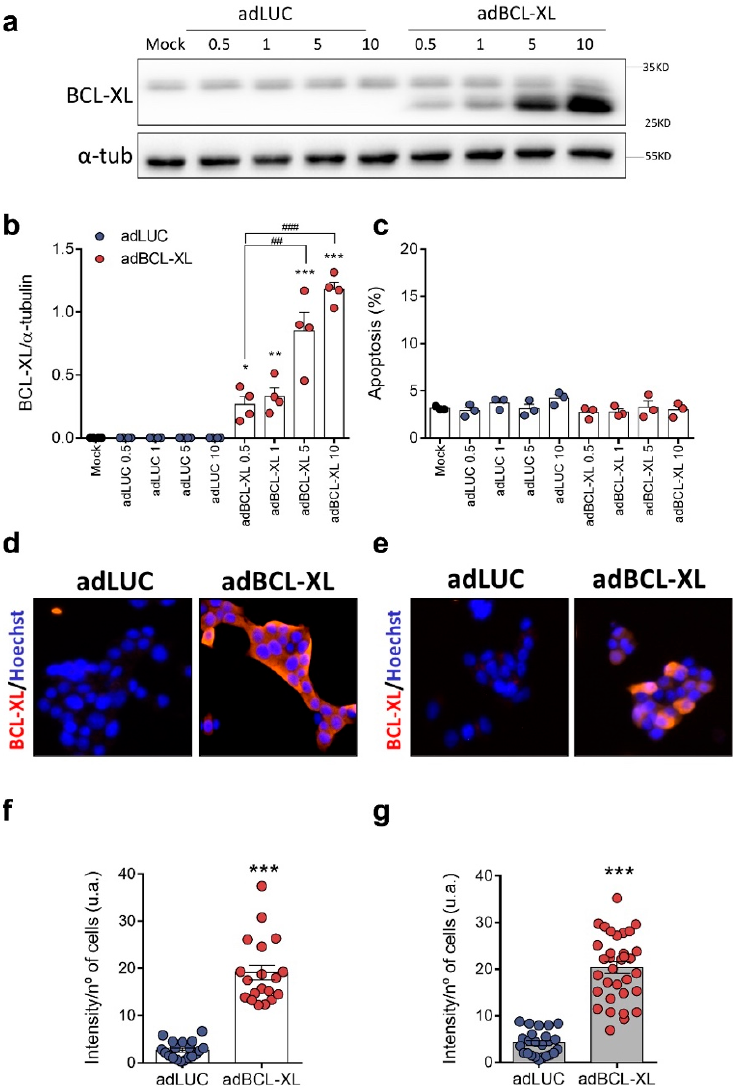
Figure 1. BCL-XL overexpression in rat and human β -cell lines. INS-1E ( a – d , f ) and EndoC- β H1 cells ( e , g ) were infected with adenoviral (ad) vectors encoding luciferase (adLUC, blue dots) or BCL-XL (adBCL-XL, red dots). After 48 h of recovery, protein expression and viability were assessed. ( a , b ) Protein expression was measured by Western blot. A representative image of four independent experiments is shown in ( a ), and densitometry results are presented for BCL-XL ( b ). ( c ) Apoptosis was assessed using HO/PI staining. Results are the means ± SEM of 3–4 independent experiments, where each dot represents an independent experiment. * p ≤ 0.05, ** p ≤ 0.01, and *** p ≤ 0.001 vs. Mock; ## p ≤ 0.01 and ### p ≤ 0.001 as indicated by bars. One-way ANOVA. ( d – g ) BCL-XL protein expression was analyzed by immunocytochemistry in INS-1E ( d , f ) and EndoC- β H1 cells ( e , g ). BCL-XL is shown in red and Hoechst 33342 in blue. Representative images (magnification ×20) are shown in ( d , e ) and densitometry results are presented for BCL-XL ( f , g ). Results are means ± SEM of 19–33 images, where each dot represents an image (4 independent experiments per cell line). *** p ≤ 0.001 vs. adLUC. Two-tailed unpaired Student’s t -test.